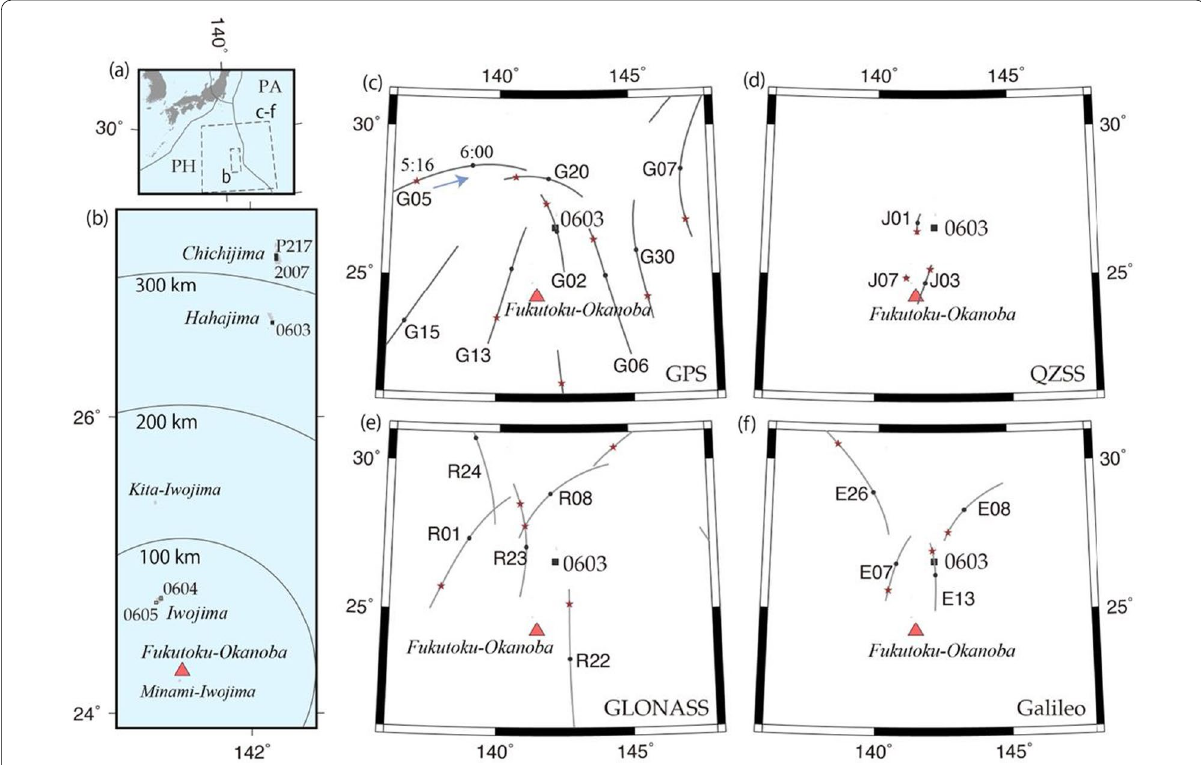
Fig. 1 A map a showing the boundaries of the Pacific (PA) and the Philippine Sea (PH) Plates and the coverages of the other maps. b Shows the locations of the volcano Fukutoku-Okanoba, which erupted in 2021 August, and three islands, Iwojima, Hahajima, and Chichijima, where five GEONET stations are deployed. Maps in c–f show sub-ionospheric point (SIP) tracks 5.1–6.9 UT calculated assuming a thin ionosphere at 300 km altitude for the pairs of the station 0603 and four different GNSS, GPS ( c ), QZSS ( d ), GLONASS ( e ), and Galileo ( f ). Red stars and black circles on the trajectories show time marks of the onset (5:16 UT) of the oscillation and 6:00 UT. A satellite SIP therefore moves in the direction from the red star toward the black